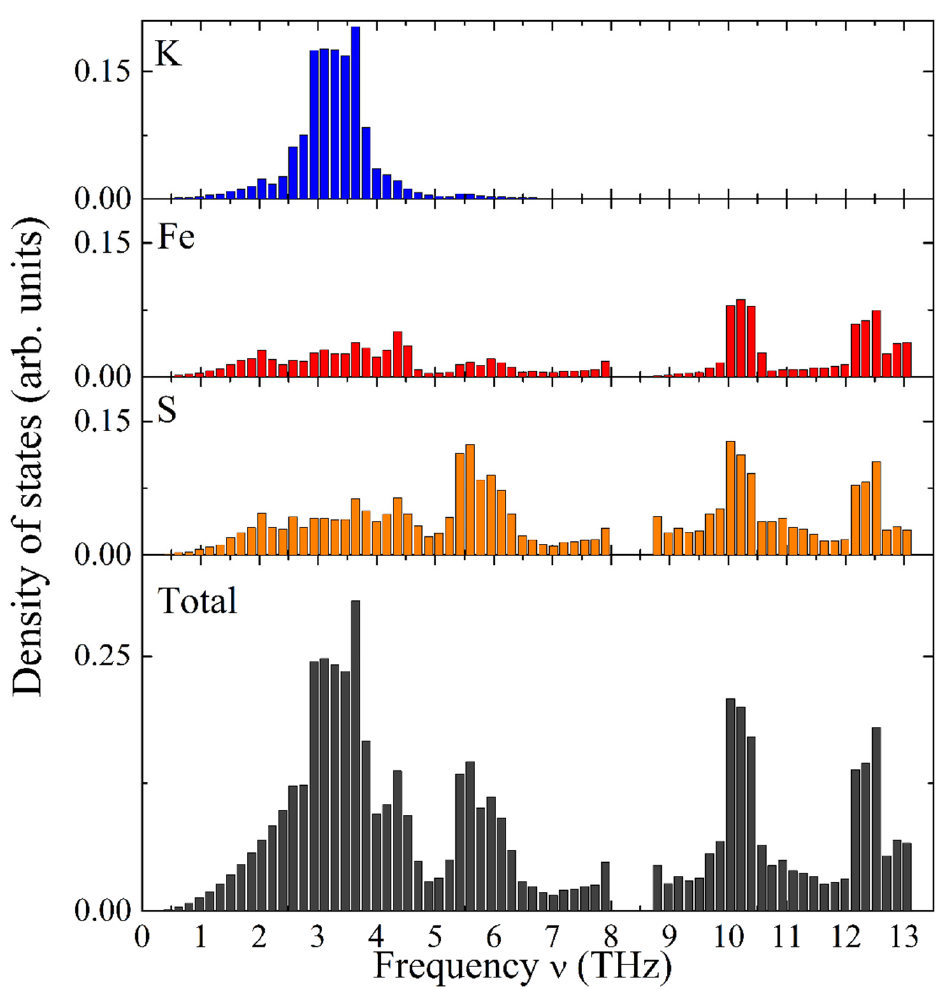
Figure 6. Calculated PDOS as a function of frequency in KFeS 2 : element-specific (K, Fe, and S atoms from top towards bottom) and the total PDOS (bottom).